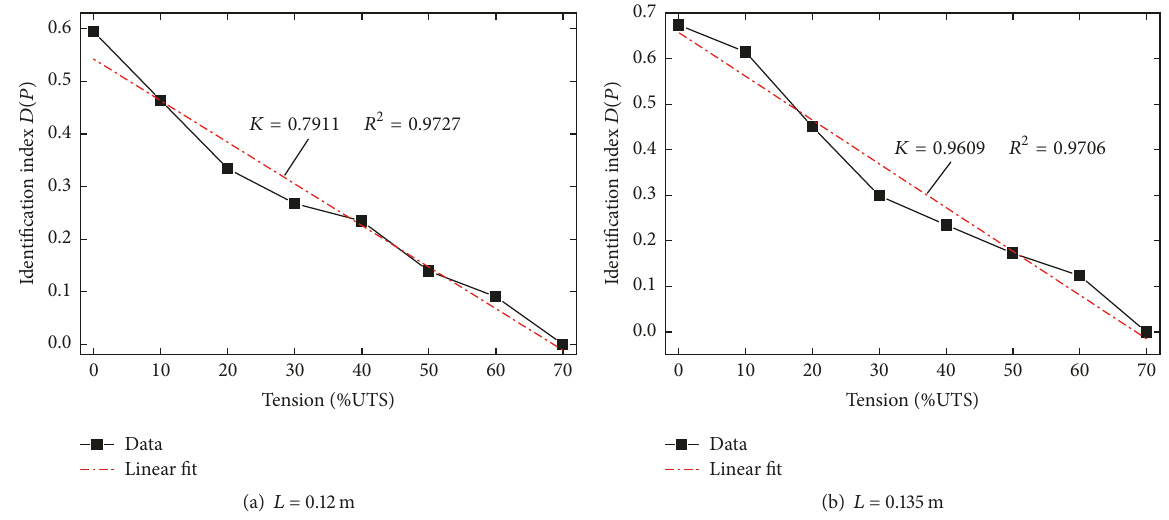
Figure 7: Effects of propagation distance on the proposed identification index ( 𝐷(𝑃) ).